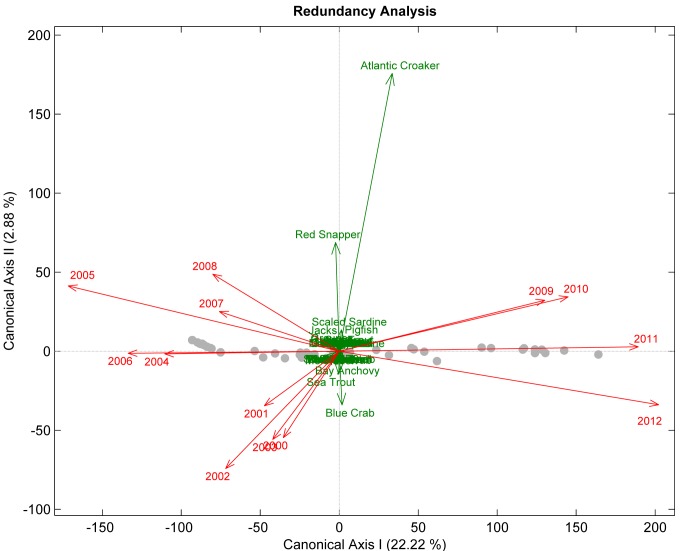
Redundancy Analysis Plot of Year and CPUE per Functional Group.Redundancy analysis shows the functional groups (green text and vectors) most associated with the programmatic changes in the SEAMAP program according to the year-pattern (red text and vectors). The year-pattern refers to the geographical locations described as points in the operating model. Approximately 25% of the variability in functional group abundances is explained by the sampling year-pattern in two canonical axes. In general post-2009 changes have benefited only a few species, in particular Atlantic Croaker.